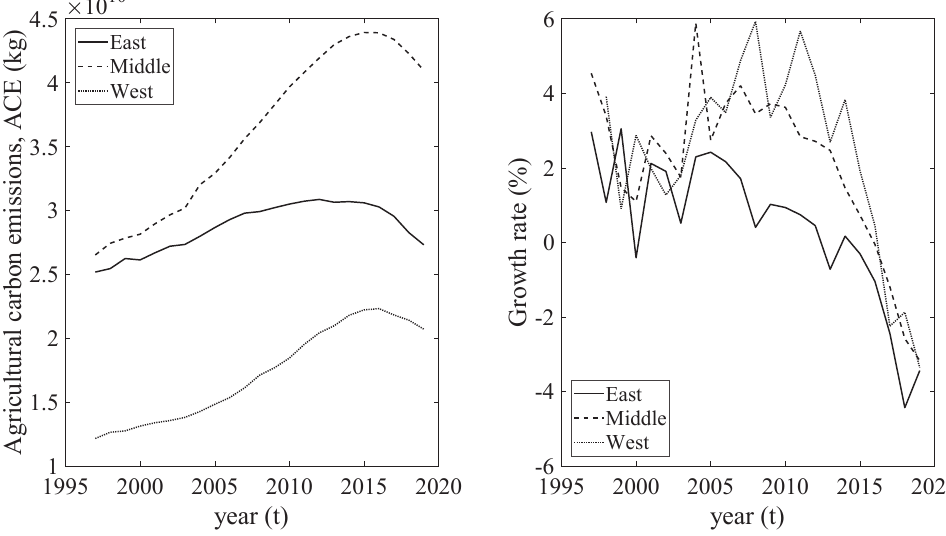
Figure 4. Agricultural carbon emission (ACE, kg) and its growth rate (%) by regions. The second graph in Figure 4 gives us the growth rates. Generally, the growth rates of the middle and western regions have a similar time tendency. However, the growth rate of the eastern region is obviously lower than that of the other two regions. One of the possible reasons is that the overall technical level of the eastern region is higher than that of